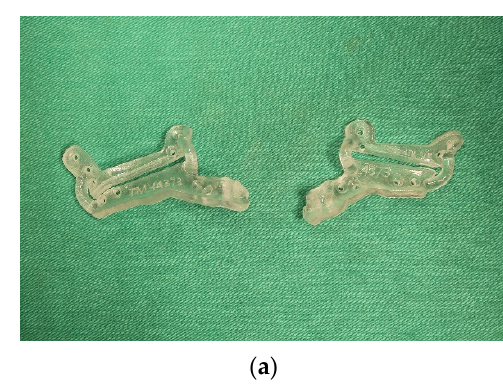
and position, which were then fixed by the fixation plates.